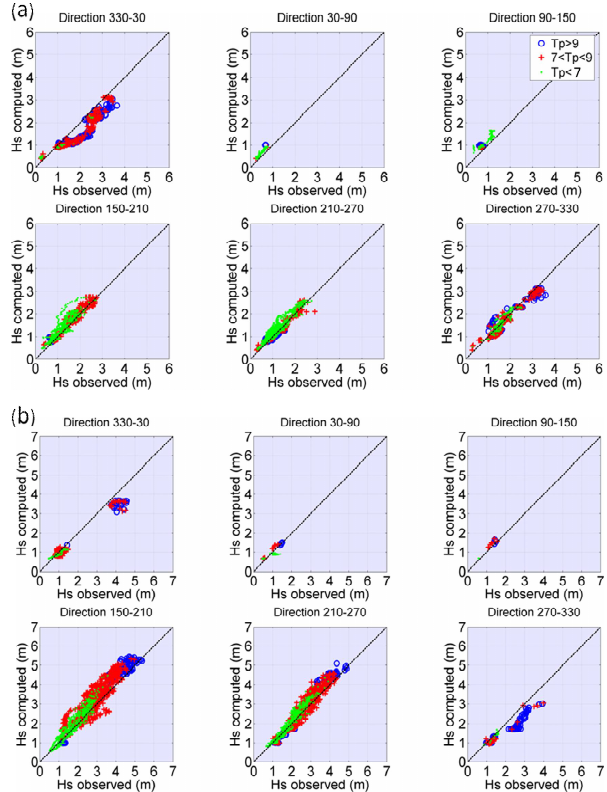
Figure 9. Scatter plot of observed significant wave height H s ver- sus computed, for every 60 ◦ of observed incoming mean wave di- rection, for different peak wave period, T p . Green – observed H s with T p <7s; red – 7< T p <9s; blue – T p >9s. (a) month of July, (b) month of November. Location: K13